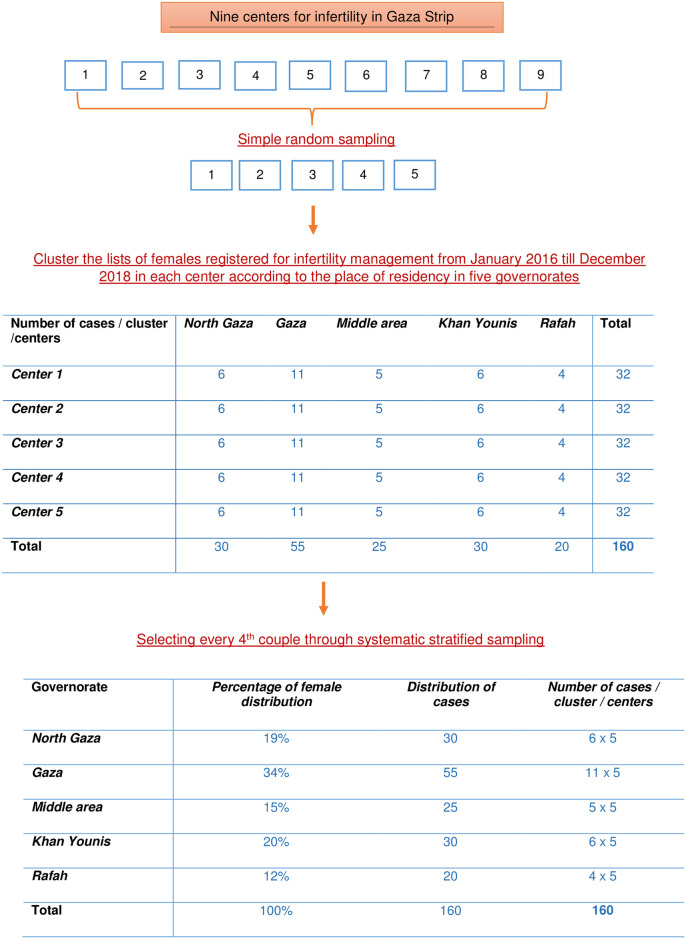
Flowchart for sampling technique and study population selection.